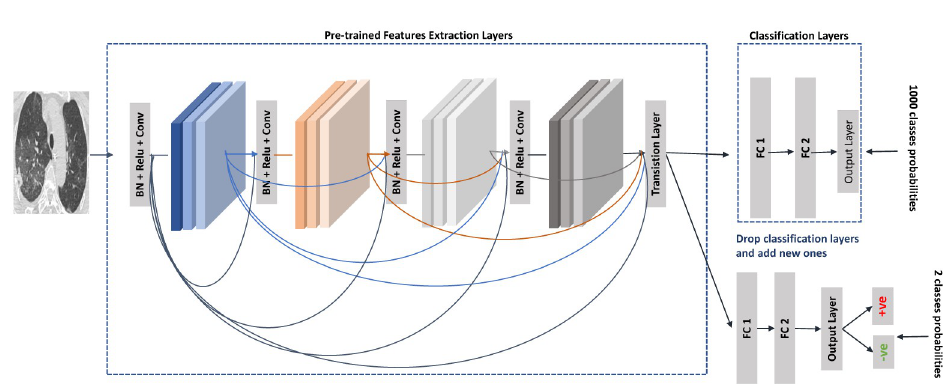
Fig 1. Transfer learning example: DenseNet201 pre-trained feature extraction